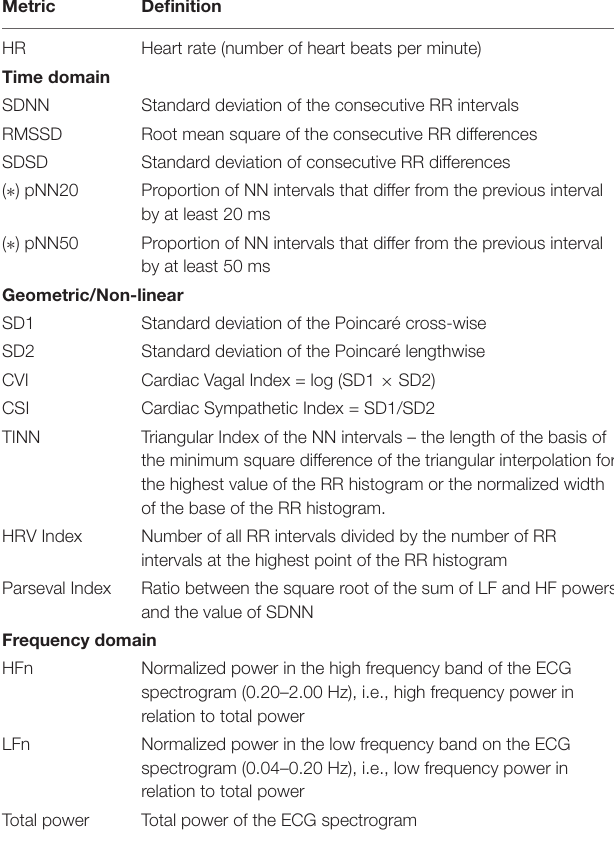
TABLE 1 | HRV metrics: abbreviations and